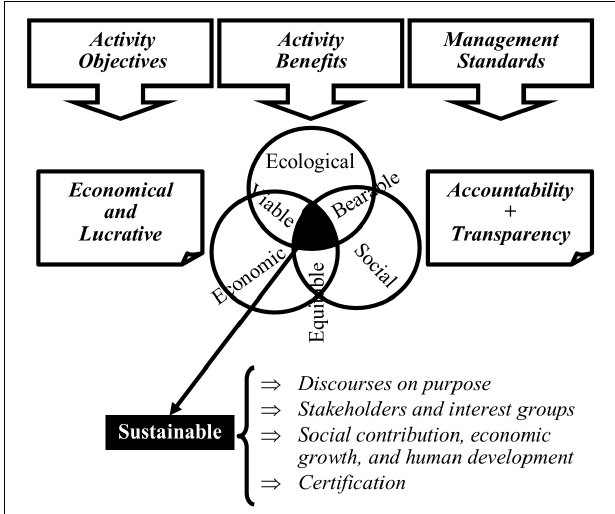
FIGURE 1 | B Corps’ operating